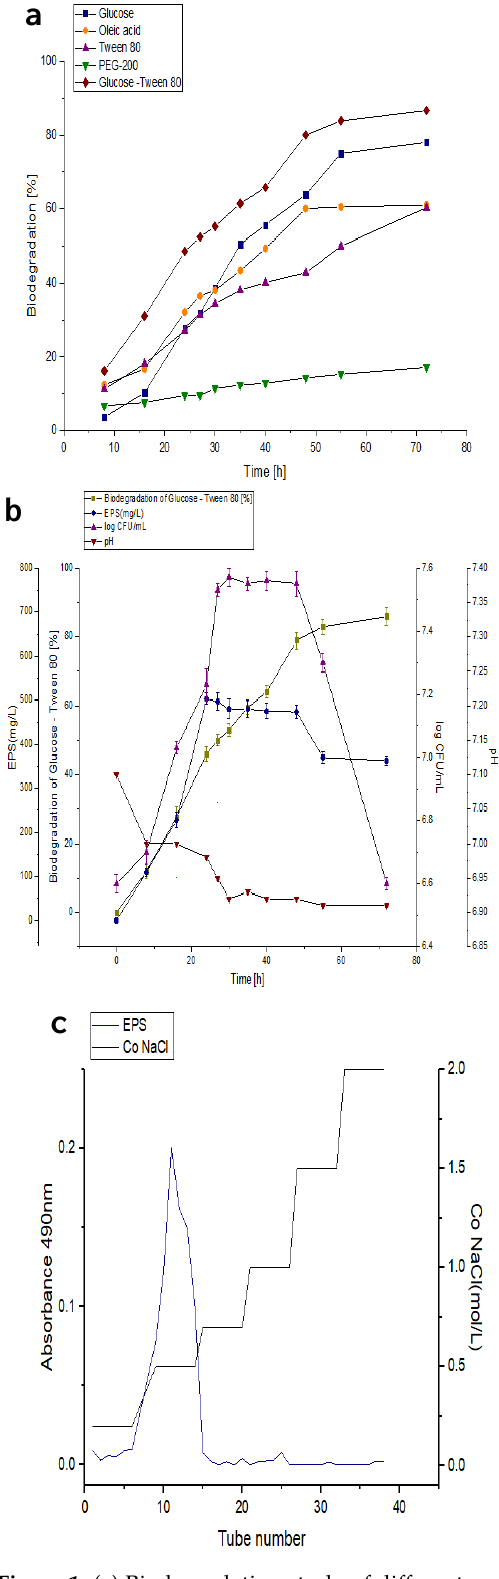
Figure 1. ( a ) Biodegradation study of different carbon sources (glucose, oleic acid, Tween 80, PEG 200 and glucose–Tween 80) from Bacillus amyloliquefaciens . ( b ) Optimisation of the production EPS from B. amyloliquefaciens . ( c ) Elution curve obtained from the purification of EPS RT7 under MGM with glucose–Tween